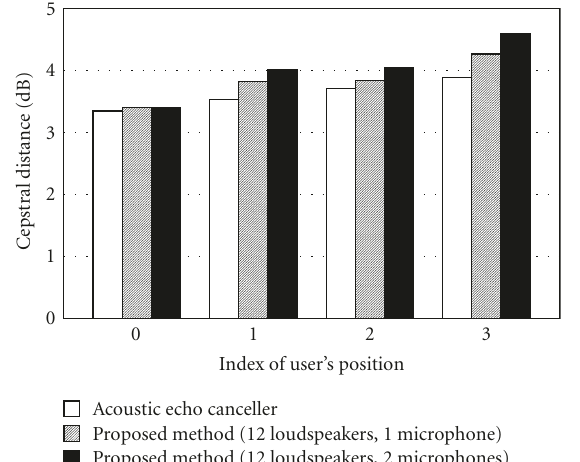
Figure 14: Cepstral distance in various positions when 12 loud- speakers are used for the proposed method.